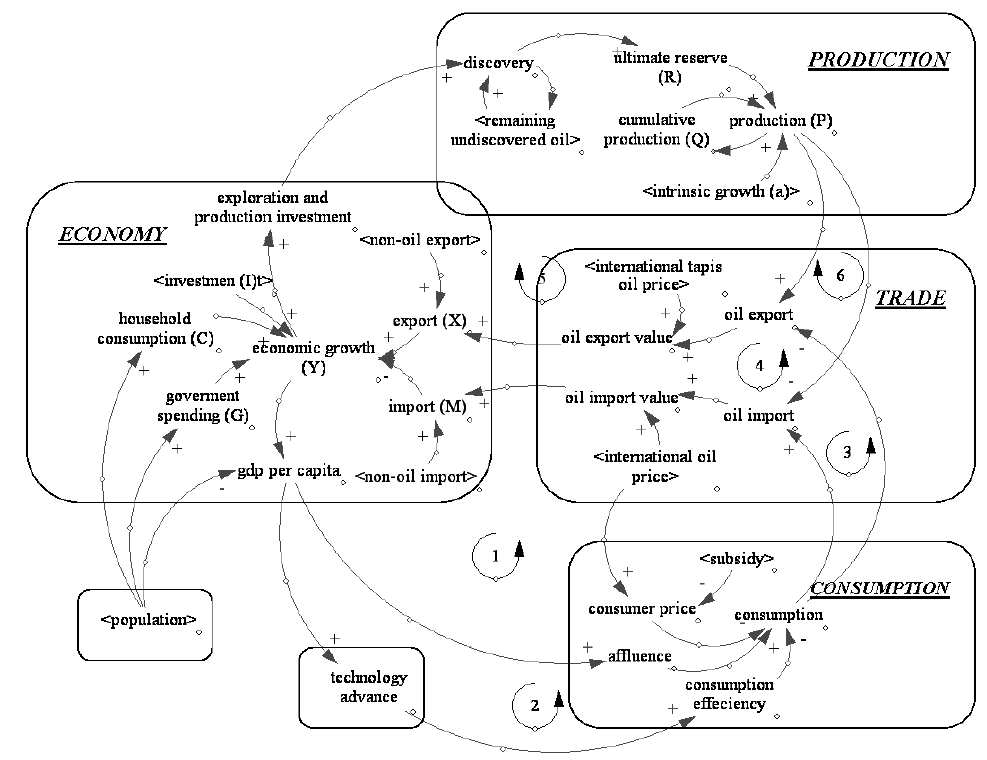
Figure 14. Causal loop diagram of the